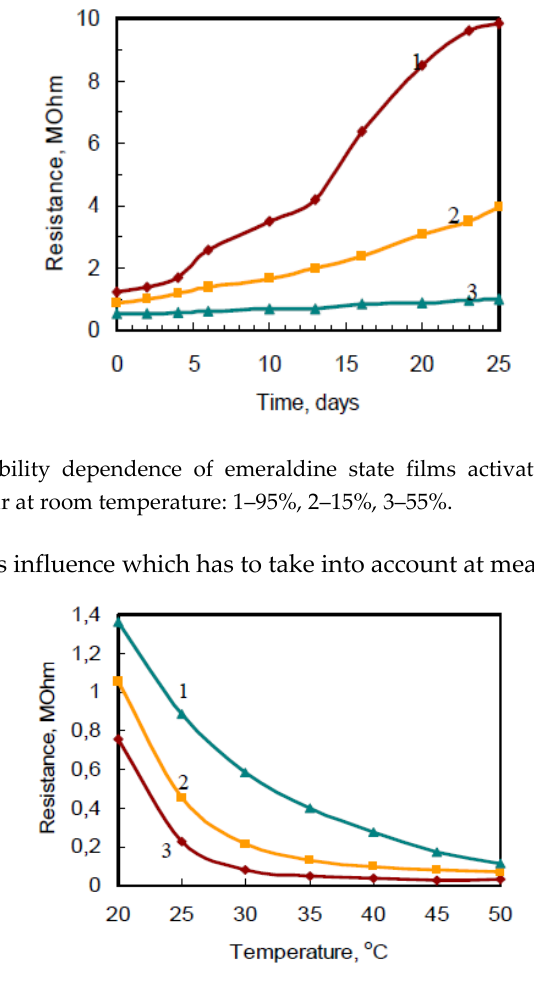
Figure 4. Typical temperature dependence of PANI films’ resistance in the presence of NH 3 with concentration 1 ppm: 1—PANI, modified with H 6 P 2 W 18 O 62 ; 2—PANI, modified with (NH 4 ) 9 P 2 W 3 Mo 15 O 62 ; 3—unmodified